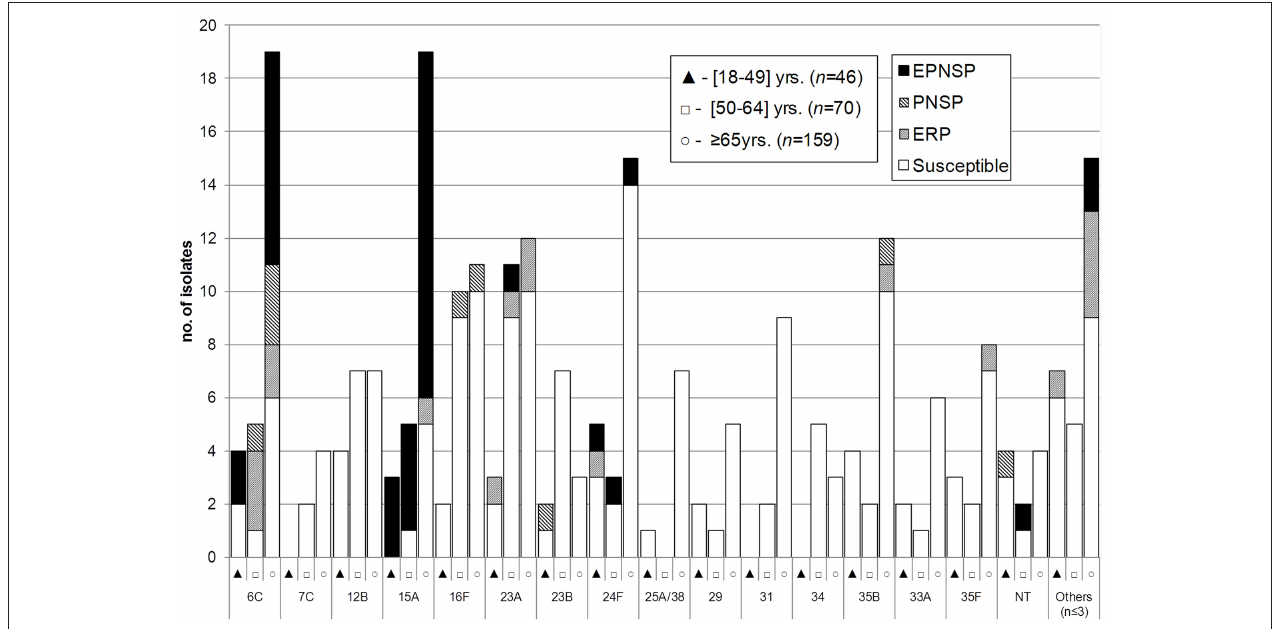
FIGURE 3 | Isolates expressing serotypes not included in any pneumococcal vaccine causing invasive pneumococcal disease in adult patients ( ≥ 18 years) in Portugal, 2012–2014. See legend of Figure 1 . NT, non-typable. Isolates expressing serotype 25A and 38 could not be distinguished phenotypically and are represented together. Only serotypes including n > 3 isolates are discriminated.